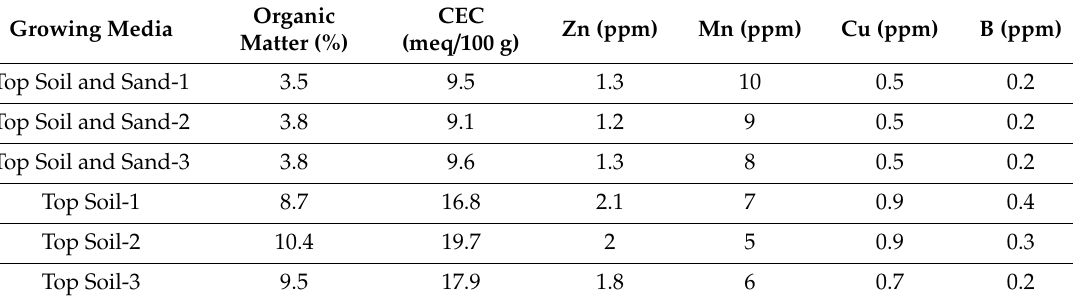
Table 1. Media analysis was replicated 3 times in top soil, and in top soil and sand mixtures, and the amount of zinc, manganese, copper and boron (in ppm), the organic matter content (%) and CEC (meq / 100 g) were